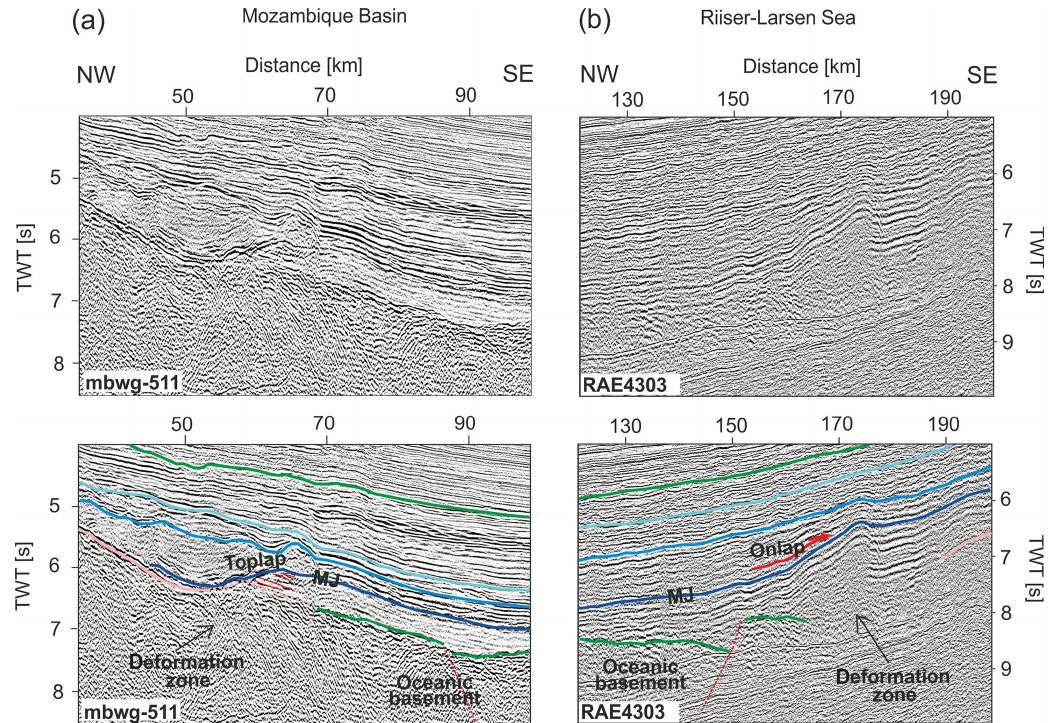
Figure 3. Close-up view of the zone of deformed basement in the Mozambique Basin (a) and Riiser-Larsen Sea (b) presented in Fig. 2. The lower panels show the interpreted sections of the profiles. The basement is distinctively deformed and faulted. Overlying post-rift sediments are deformed and indicate toplap (a) and onlap (b) geometries. Unconformity MJ, with an inferred age at the transition from the Middle to Late Jurassic, seals the deformation. Blue sedimentary horizons indicate Late Jurassic and Middle Cretaceous strata; the green horizon near the top is Late